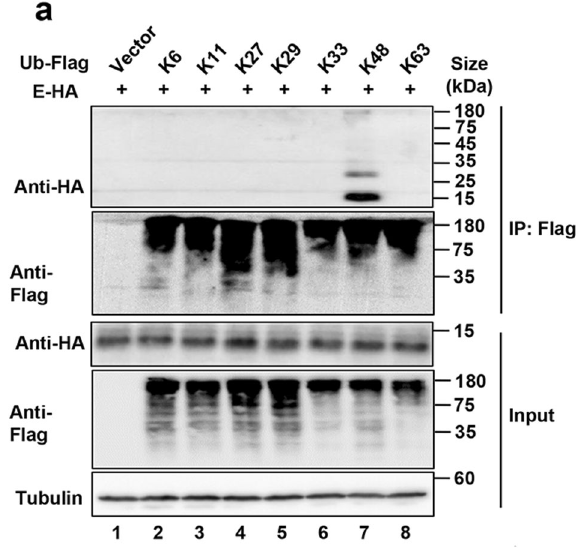
Fig. 3a E was ubiquitinated via K48-linked but not K6, K11, K27, K29, K33 or